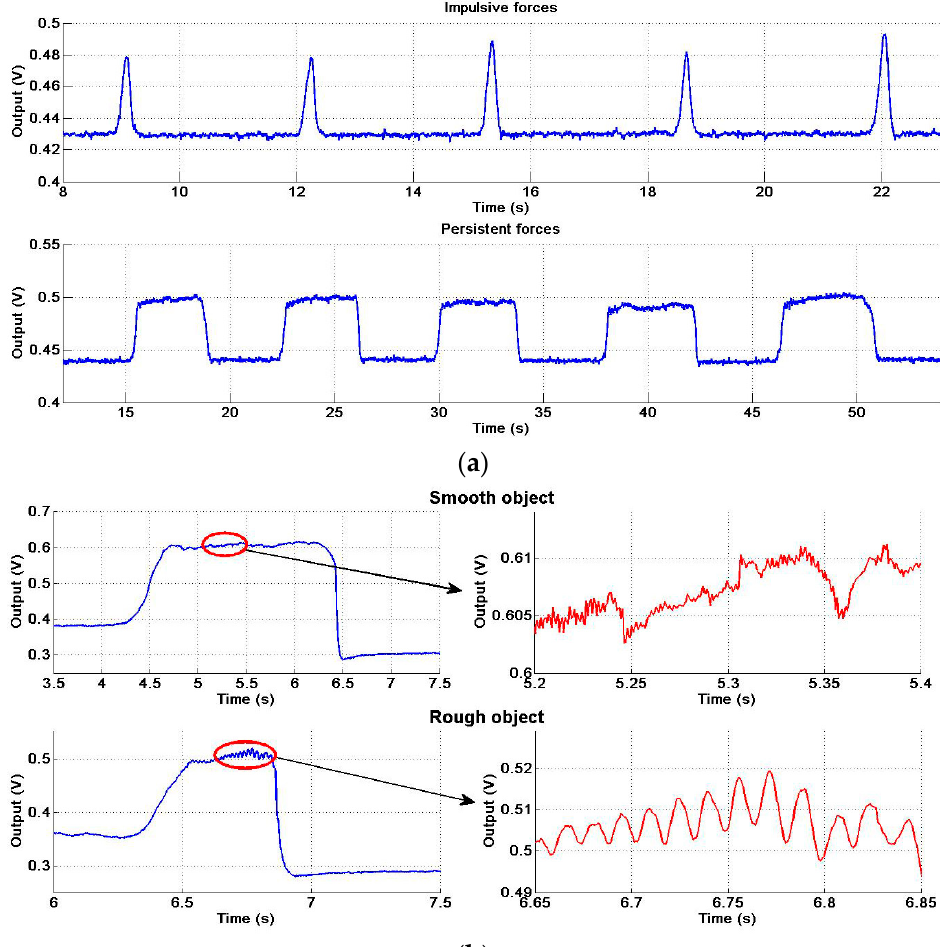
Figure 12. The experiment results of sensing slippage. ( a ) the objects with tendency of slip under impulsive and persistent force; ( b ) the smooth and rough object slipping.